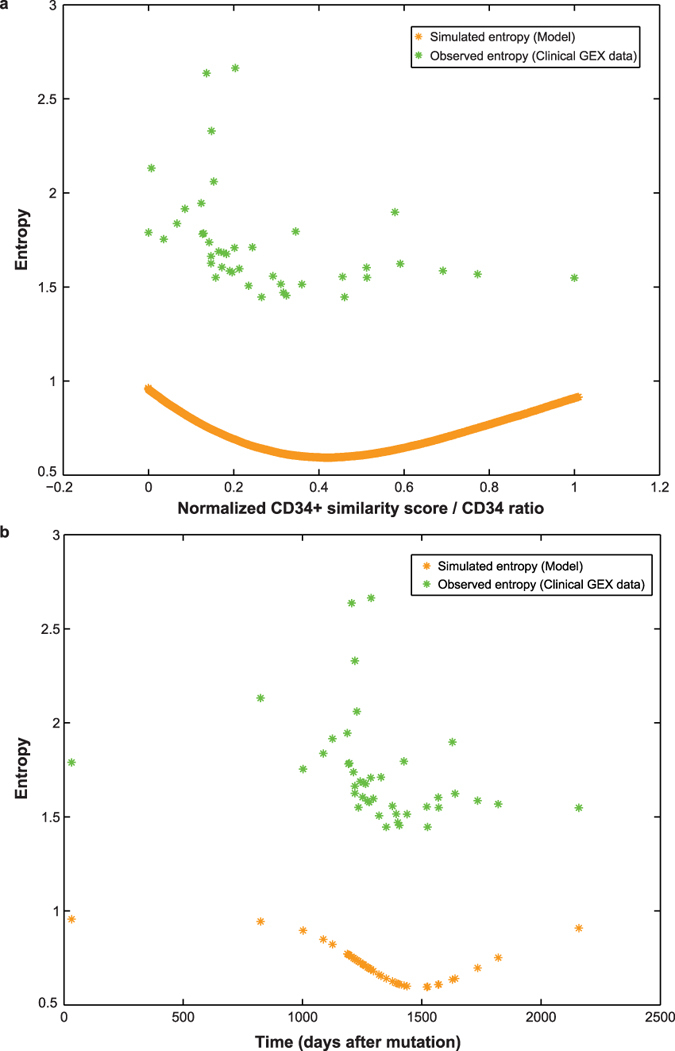
Assessment of CP patient disease status and progression risk.(a) Data points represent clinical samples of 42 CP patients (green asterisks) (GSE4170, Radich et al. 2006a). Normalized CD34+ similarity score combined with entropy of patient gene expression and simulated entropy maps CP evolutionary time intervals between model and patients. (b) 42 CP patients (green asterisks) as in a. plotted by observed entropy from clinical gene expression data and simulated entropy from the model converted to time (days after initial HSC mutation). Timespan covers ~6 years in accordance with the model.